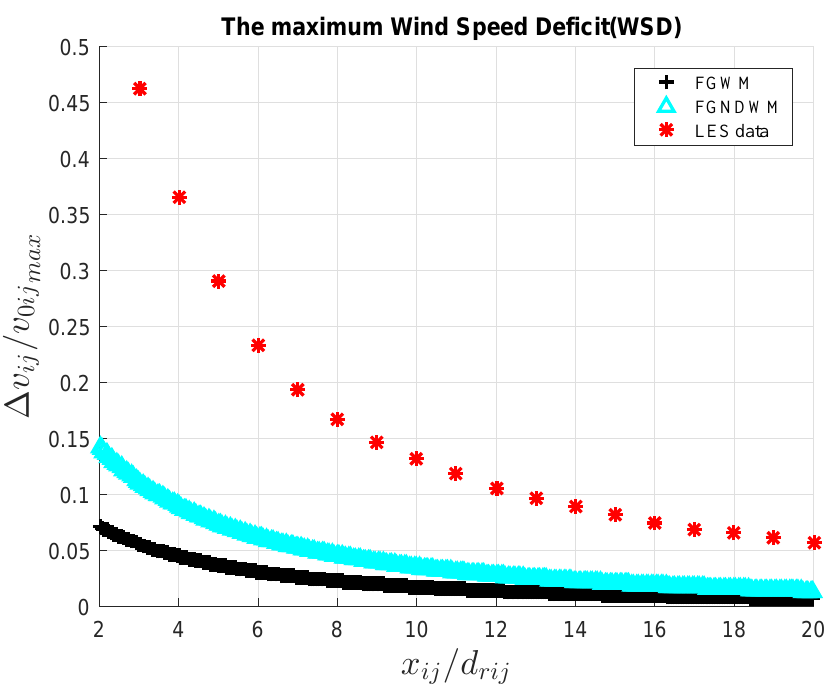
Figure 8. The portrait of the maximum Wind Speed Deficit (WSD) in Case d (fitted by LES data, i = 1,2, · · · , N ; j = 1,2, · · · , N ).